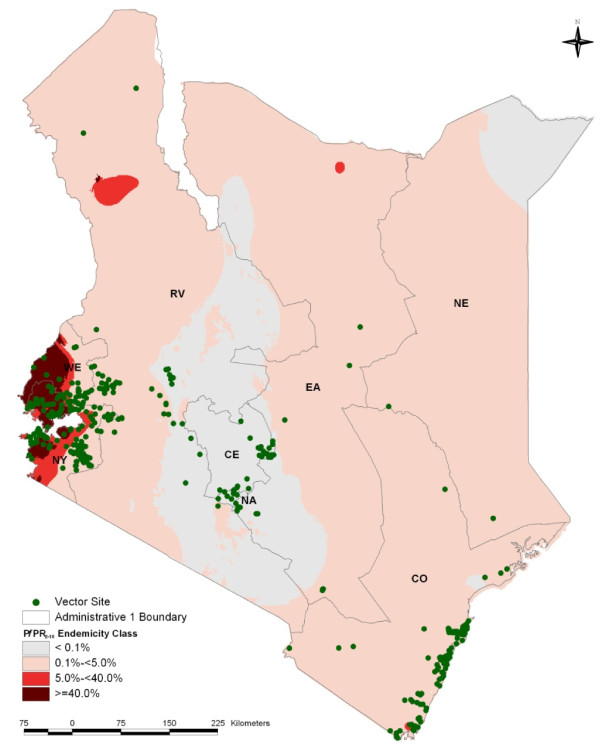
Map of Kenya showing the distribution of 492 spatially unique survey sites displayed over the first-level administrative units (Provinces) and the predicted PfPR2-10 endemicity classes: PfPR2-10> = 40%; PfPR2-10 5-39%; PfPR2-10 0.1% < 5%; and PfPR2-10 < 0.1% [21]as shown in Figure legend.